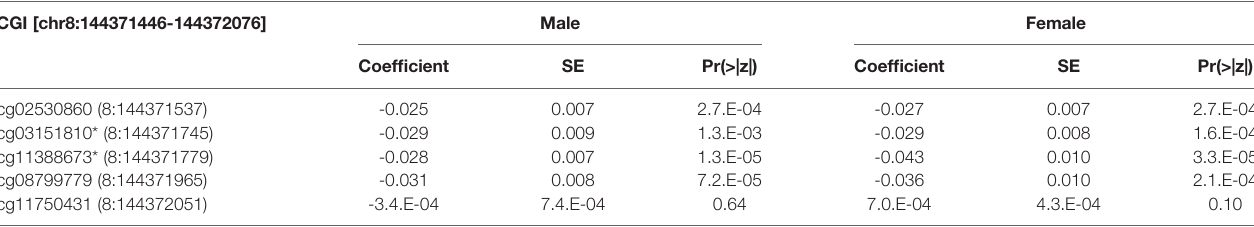
chr, chromosome; SE, standard error. Rlm was performed adding 3 covariates; cesarean section delivery, gestational age, and cell components (-Gran). *indicates the probes that reported to be hyper-methylated in infants cord blood born to GDM